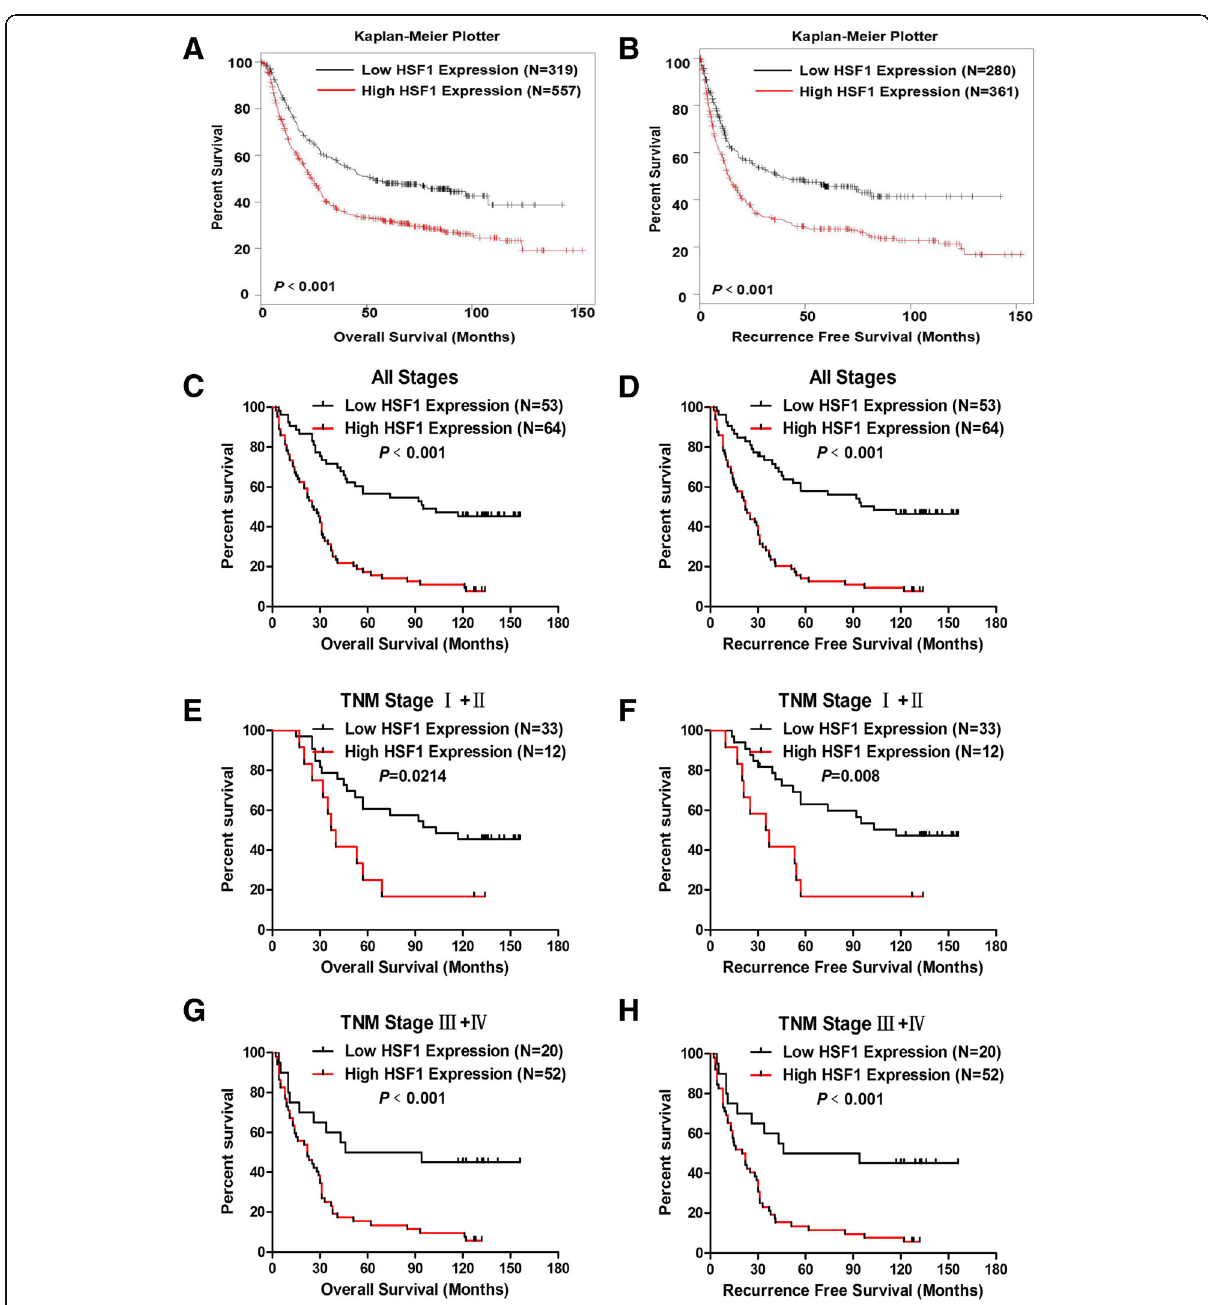
Fig. 3 High HSF1 expression in tumours predicted poor prognosis in GC patients. ( a & b ) Overall survival ( a , P <0.001) and recurrence-free survival ( b , P <0.001) curves for the GC patient groups with low and high HSF1 mRNA levels in Kaplan-Meier Plotter. ( c & d ) Patients with higher HSF1 expression had worse overall survival ( c , P <0.001) and recurrence-free survival ( d , P <0.001) than those with lower HSF1 expression ( P <0.001); ( e & f ) High HSF1 expression in GC tissues predicted worse overall survival ( e , P =0.0214) and recurrence-free survival ( f , P =0.008) in patients with early-stage GC (TNM stage: I and II);( g & h ) High HSF1 expression in GC tissues predicted worse overall survival ( g , P <0.001) and recurrence-free survival ( h , P <0.001) in patients with advanced gastric cancer (TNM stage: III and